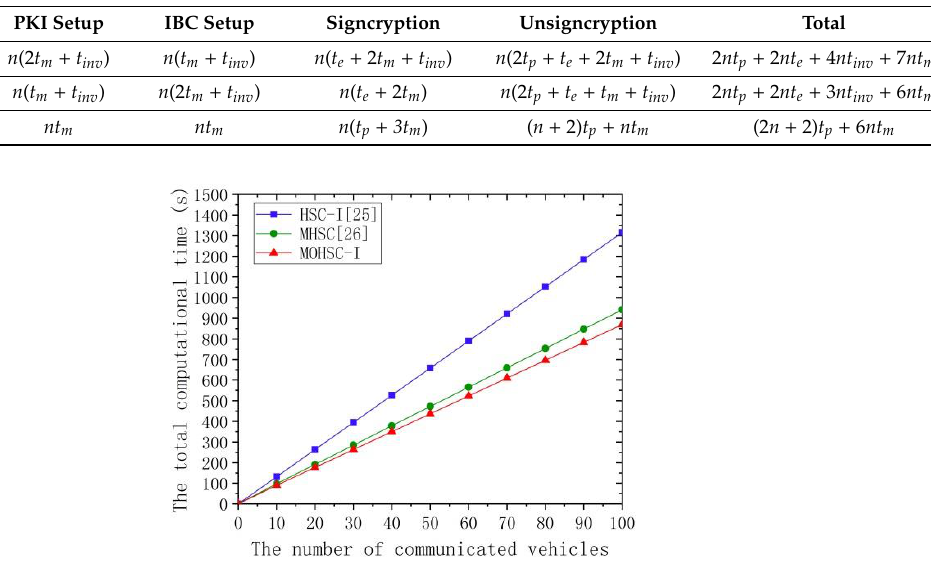
Figure 3. Comparisons of the computational time (PKI → IBC).